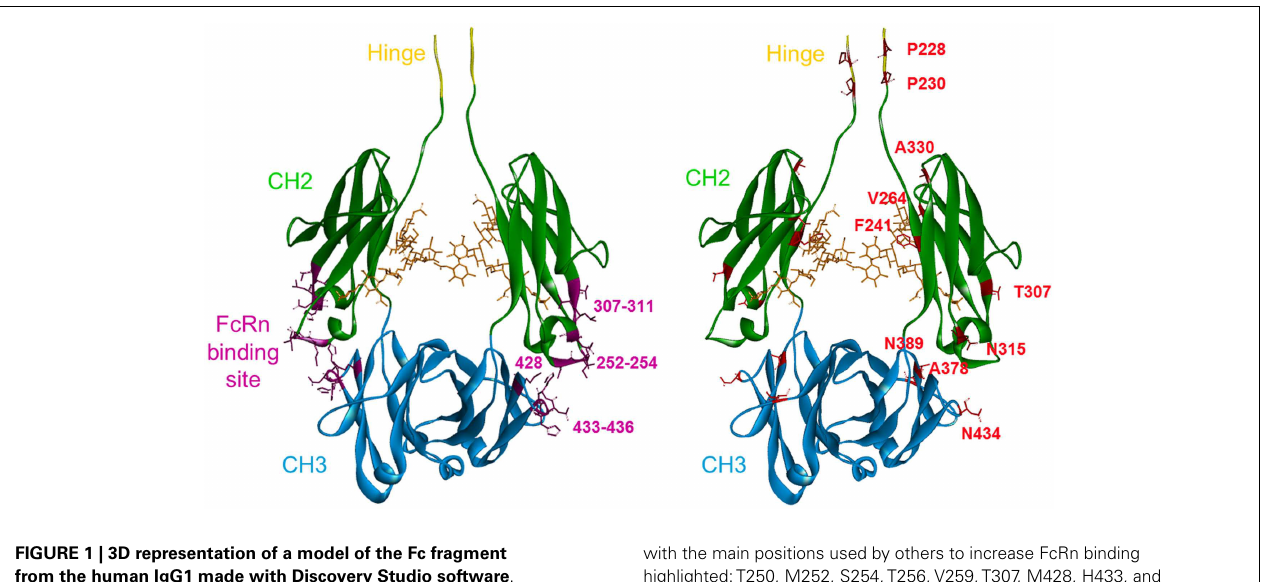
FIGURE 1 | 3D representation of a model of the Fc fragment from the human IgG1 made with Discovery Studio software . The last five amino acids of the hinge region are in yellow.The CH2 domain is in green and the CH3 domain is in blue. Left panel: in purple, the FcRn-binding site in the CH2–CH3 interdomain region,